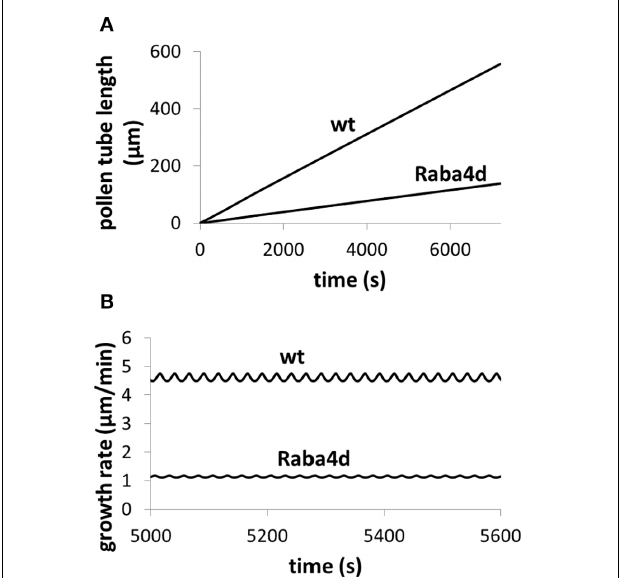
FIGURE 5 | Knockout of Raba4d, a member of the Rab family of small GTPase proteins, decreases pollen tube length. Osmolarity in the media is 0.36 Osm. Fusion rate parameter is reduced from 21.5 µ m 3 /(mM s) in wild type (wt) to 0.215 µ m 3 /(mM s) in Raba4d mutant, mimicking that Raba4d regulates membrane trafficking. After knockout of Raba4d, membrane trafficking rate decreases. (A) Qualitatively reproduces experimental observations (Szumlanski and Nielsen, 2009): in Raba4d mutant, pollen tube length is shorter than that in wild type (Szumlanski and Nielsen, 2009). Following experimental observations (Szumlanski and Nielsen, 2009), the pollen tube radius is approximately 6 and 12 µ m for wt and Raba4d respectively. Our simulations use the corresponding radius respectively. (B) Analyses pollen tube growth rate in both wild type and Raba4d